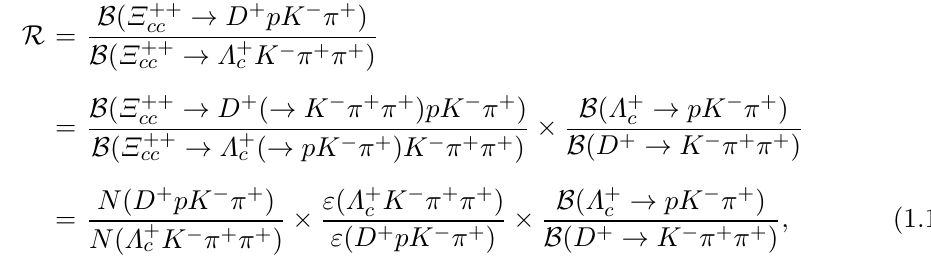
Figure 1 . The Feynman diagram contributing to the inclusive (left) (cid:4) ++ with the analogous (right) (cid:4) ++